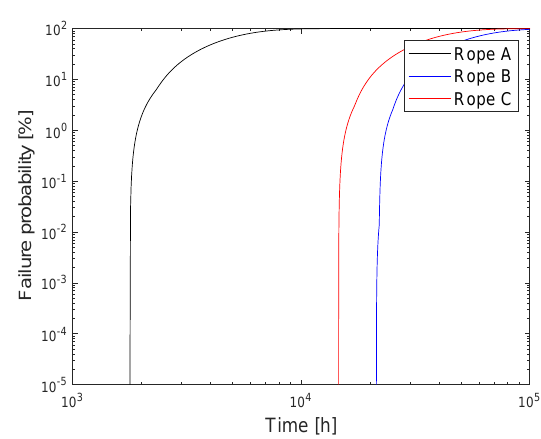
Figure 6: Failure probability of winch drivetrain utilis- ing ropes A, B and